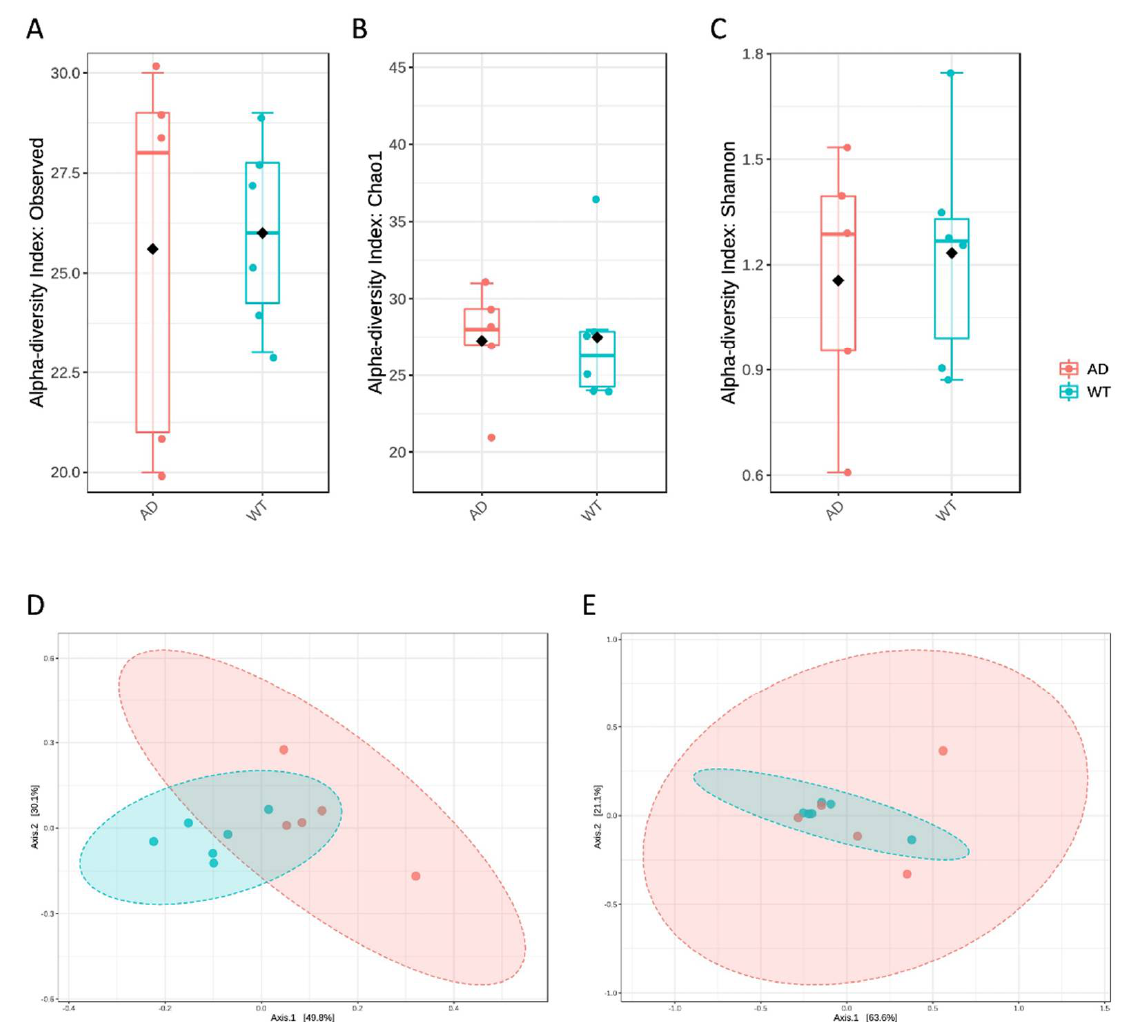
Figure 1. Diversity measures of the bacterial taxa identified in the AD and WT mice. Alpha diversity was calculated using several metrics to measure the within-group diversity and bacterial richness. In particular, observed species ( A ), Chao1 ( B ) and Shannon ( C ) indices were obtained showing no significant differences between the 2 tested conditions. β diversity was also measured using the unweighted ( D ) and weighted ( E ) UniFrac distance measures. Statistical significance was assessed by PERMANOVA test, resulting in significance ( p < 0.005) only in the case of unweighted